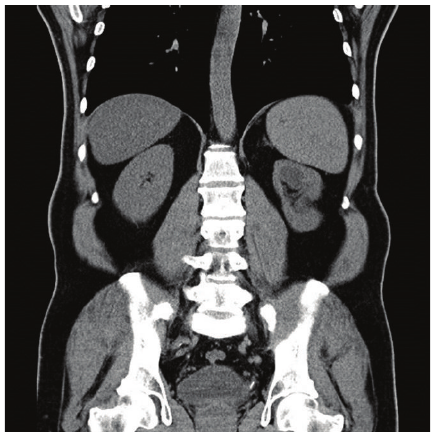
Figure 3: Postoperative CT image at the first